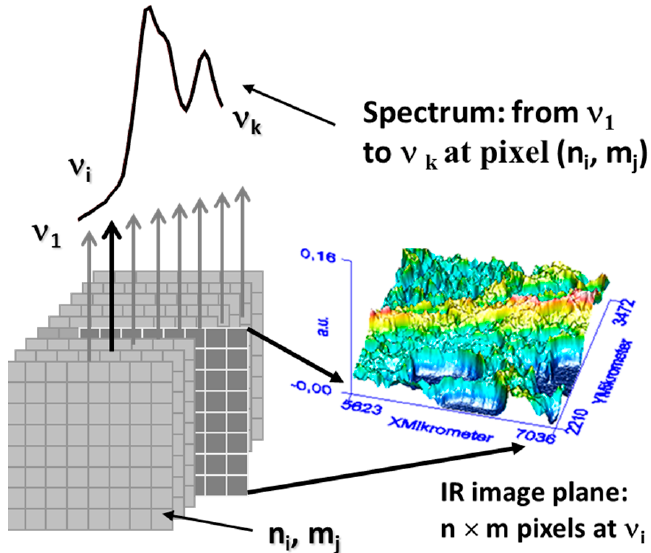
Figure 4. Schematic illustration of the hyperspectral cube principle.